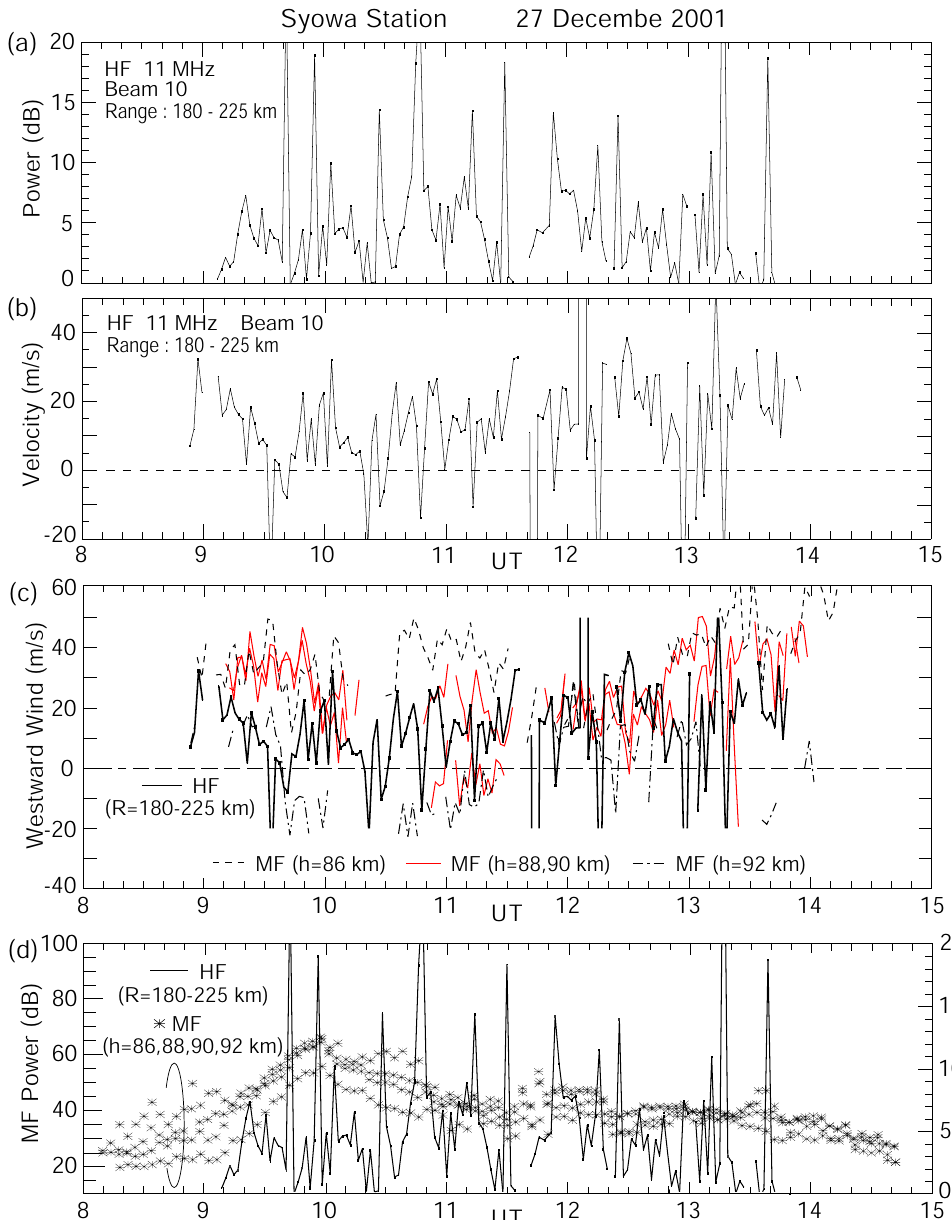
Fig. 10. Time variations of (a) echo power and (b) Doppler velocity observed at 180–225km range gate on beam 10 of the Syowa HF (11MHz) radar. (c) Time variations of westward wind observed at four altitudes with the Syowa MF radar, and of Doppler velocity at 180–225km range gate on beam 10 (looking toward the geographic east) of the HF radar. (d) Time variations of echo power observed at four altitudes with the MF radar and at 180–225km range gate on beam 10 of the HF